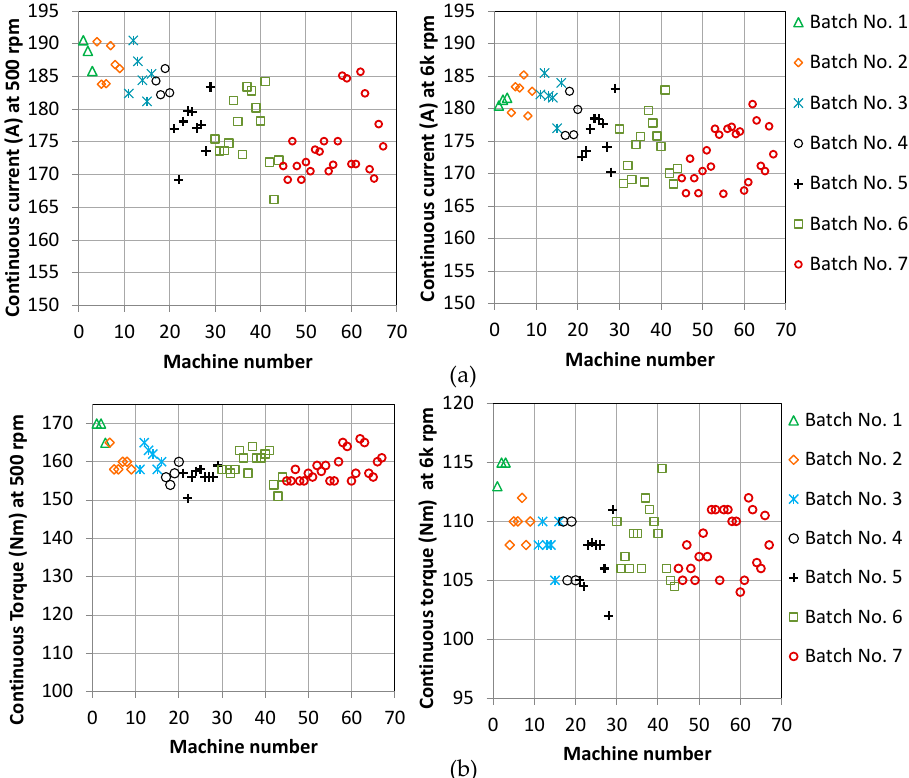
Figure 3. Measurements at 500 and 6000 rpm for several AFPMSMs: ( a ) Continuous current; ( b ) continuous torque.